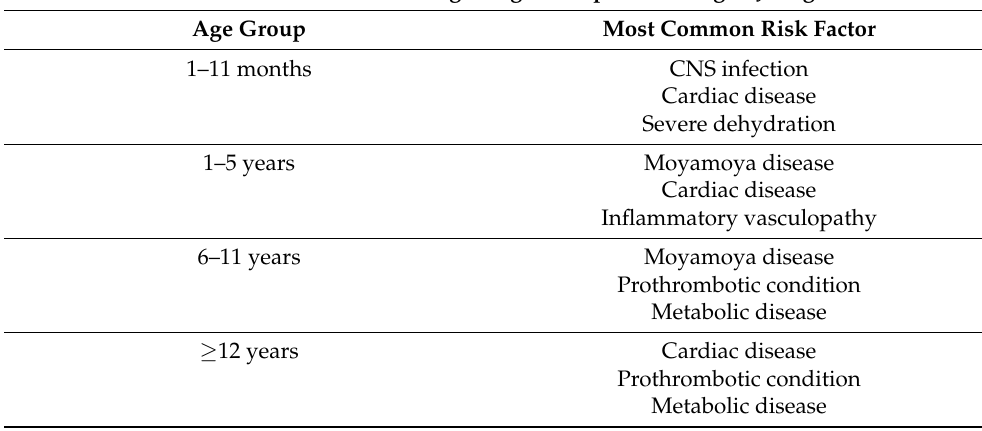
Table 1. AIS age-related risk